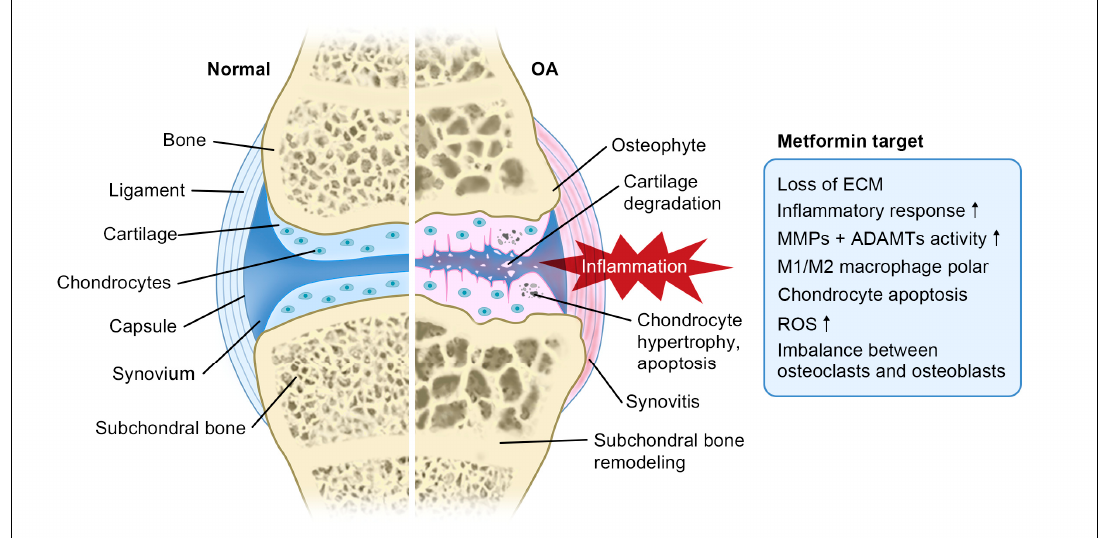
Figure 1. Pathogenesis of OA and the potential metformin targets. Note: ↑ means up-regulation.